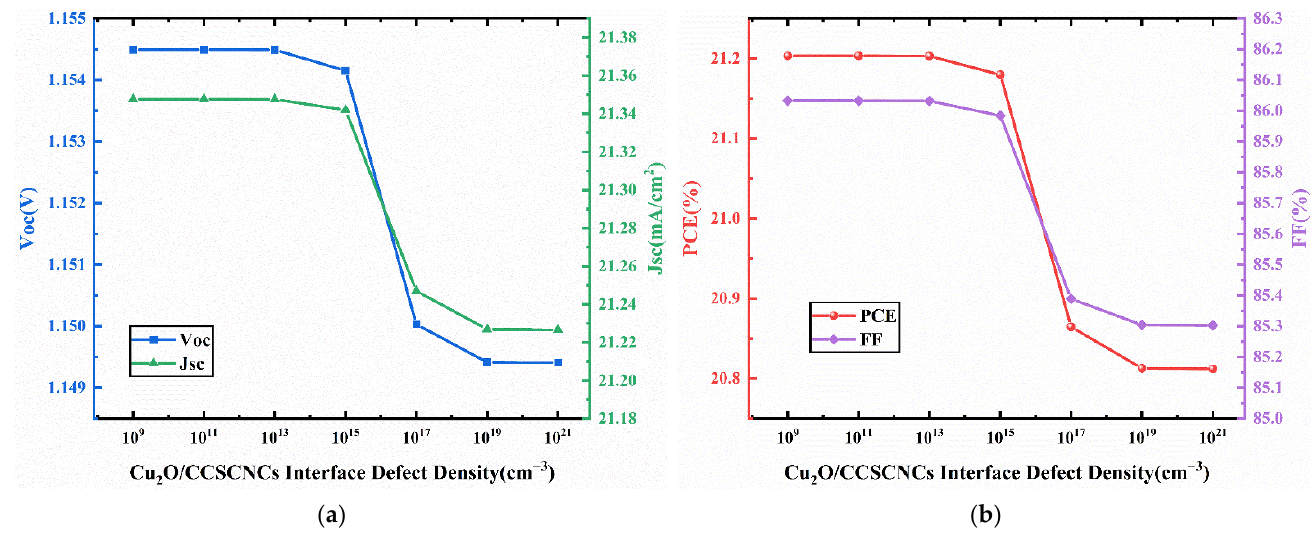
Figure 14. ( a ) Change in Voc and Jsc against Cu 2 O/CCSCNCs interface defect density variation; ( b ) change in PCE and FF against Cu 2 O/CCSCNCs interface defect density variation.